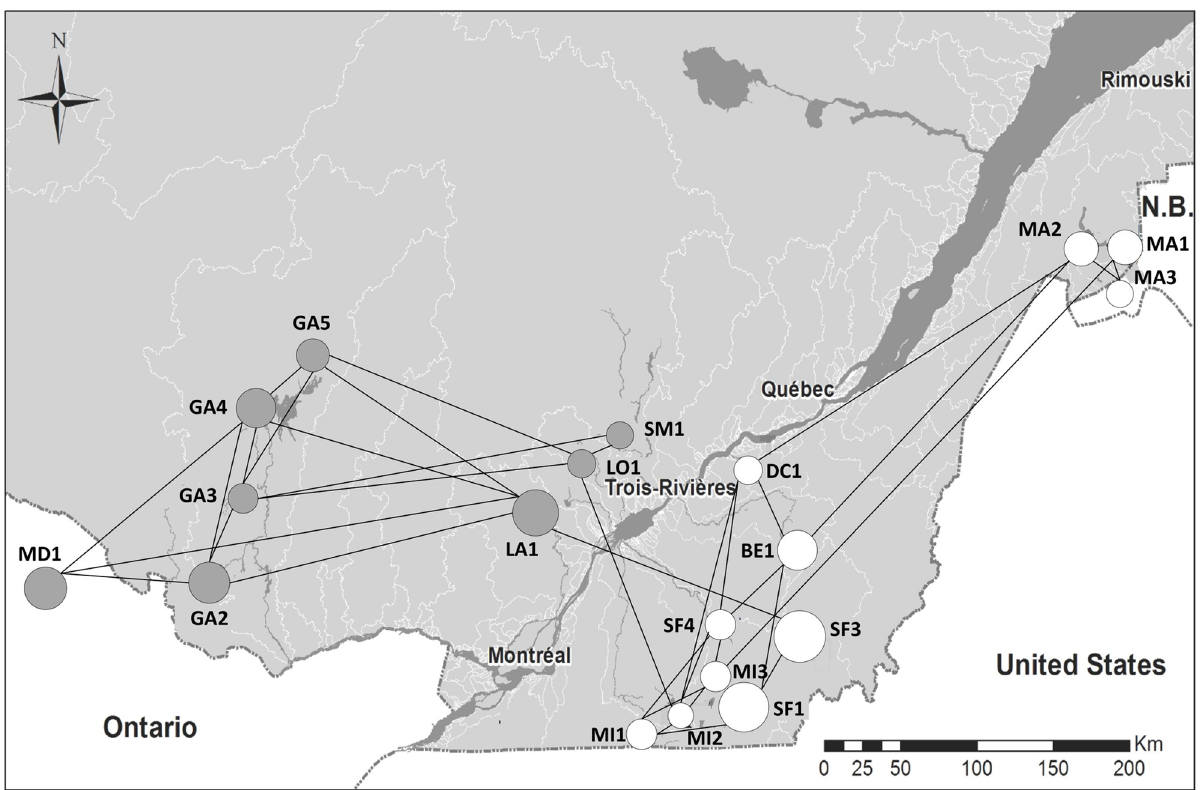
Fig 2. Population graph of 19 wood turtle populations based on conditional genetic distance (cGD). Redundant edges were pruned when they did not contribute to the overall genetic covariance structure. Node sizes are scaled according to the average inverse edge weight (AIEW), where greater AIEW values are reflected through proportinaly larger circular diameters. Populations located on the northern and southern shores of the St. Lawrence River are identified with gray and white nodes, respectively. Source: Esri. " Light Gray Canvas Map" [basemap]. https://www.arcgis.com/home/webmap/ viewer.html?layers=ed712cb1db3e4bae9e85329040fb9a49 Orignal data are from Bouchard and colleagues [56].